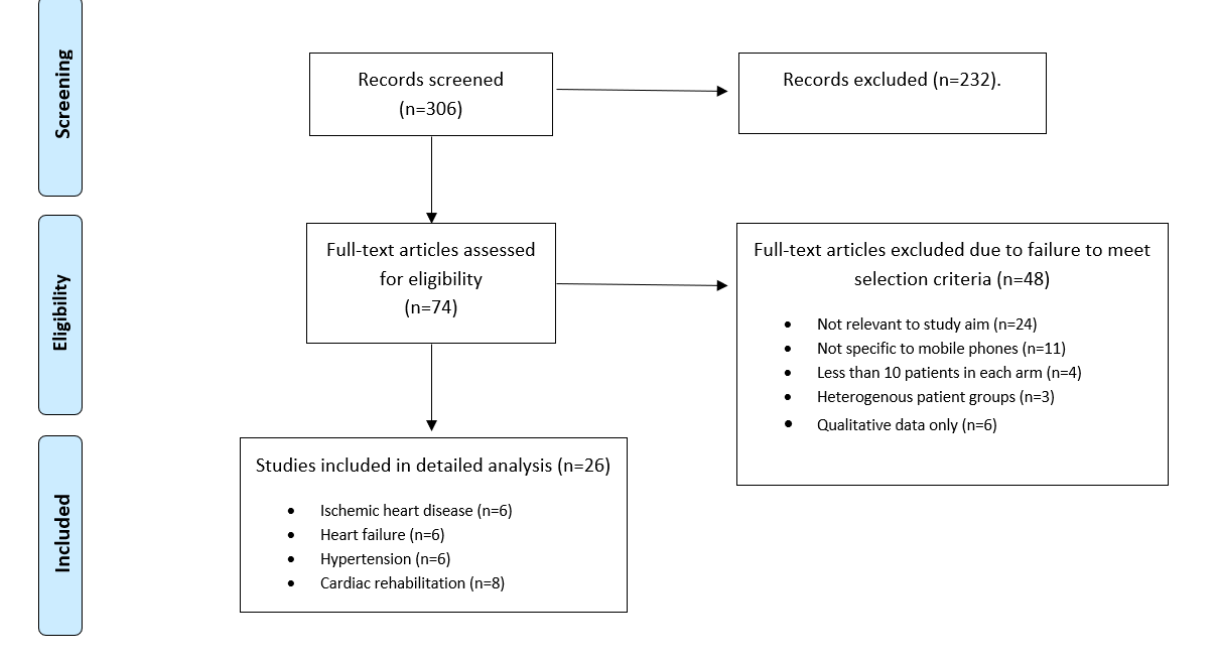
Figure 1. Search strategy and results for the Preferred Reporting Items for Systematic Reviews and Meta-Analyses (PRISMA)